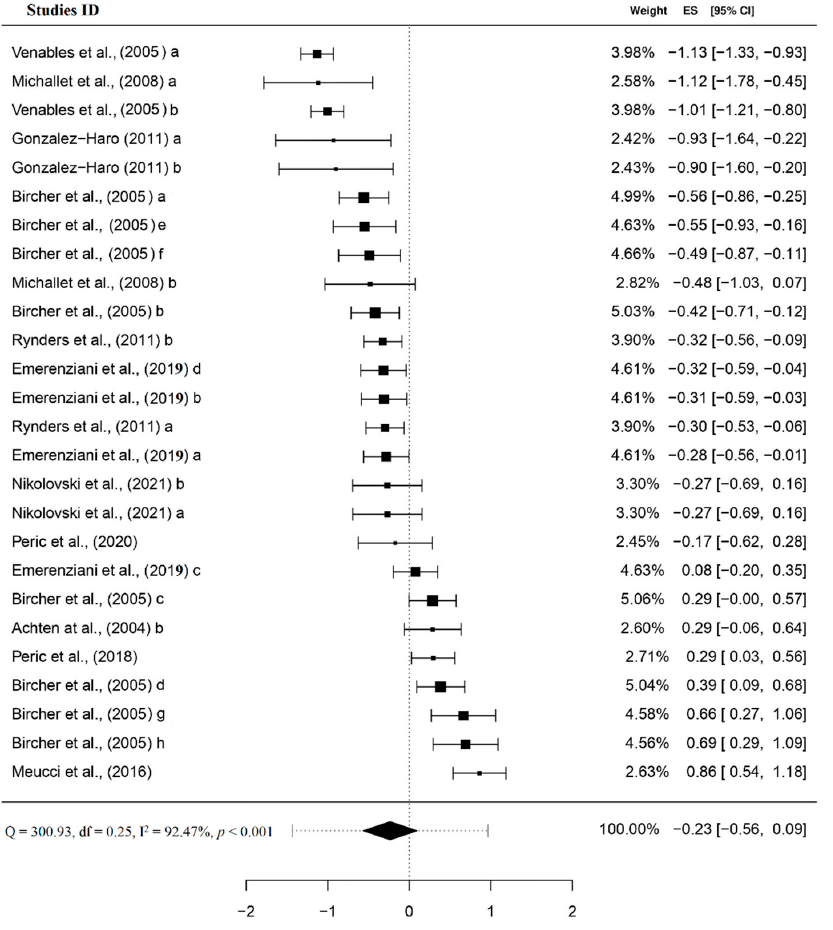
Figure 3. Forest plot reporting SMD. NOTE: Reported values for each study are presented by using random-effect model weights, ES, and 95% CI